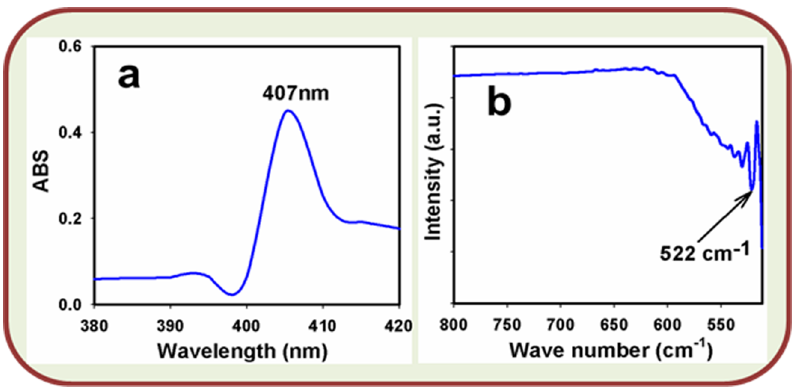
Figure 3. Studies of Optical property. (a) UV/visible spectroscopy and (b) FT-IR spectroscopy of calcined Ag 2 O 3 -ZnO